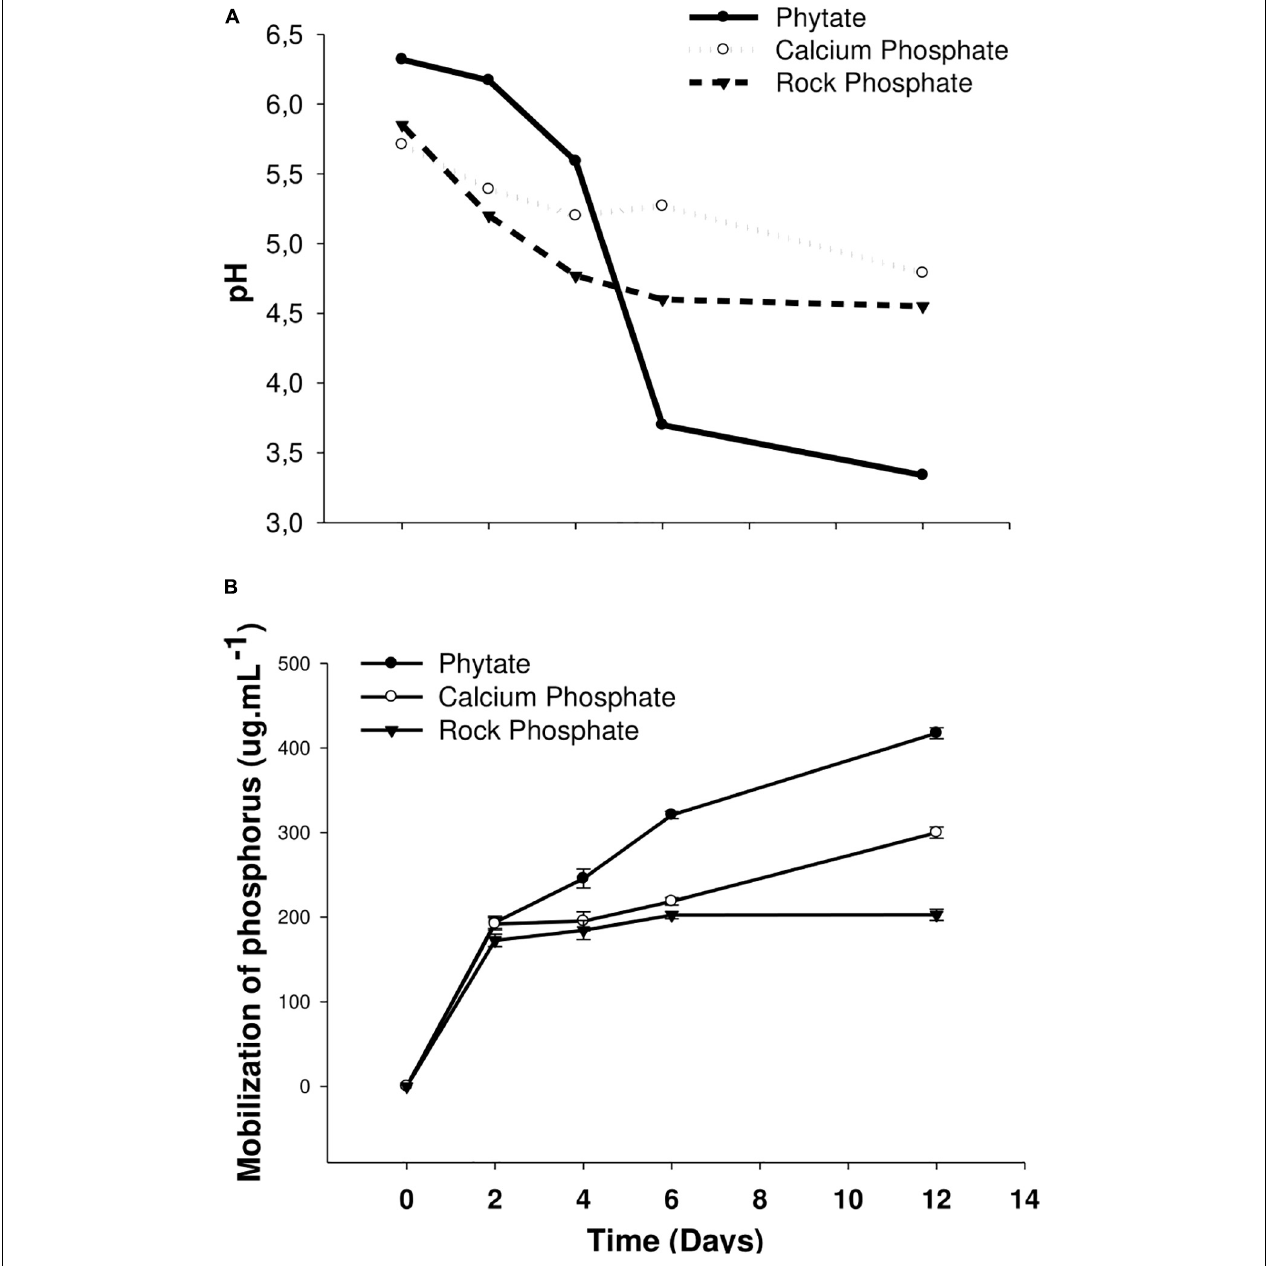
FIGURE 2 | Analysis of the behavior of pH (A) and mobilization of phosphorus (B) in three different media {Phytate, Calcium Phosphate [Ca 3 (PO 4 ) 2 ], and Rock Phosphate} inoculated with the 3AS4 strain, grown for 12 days at 28 ◦ C under